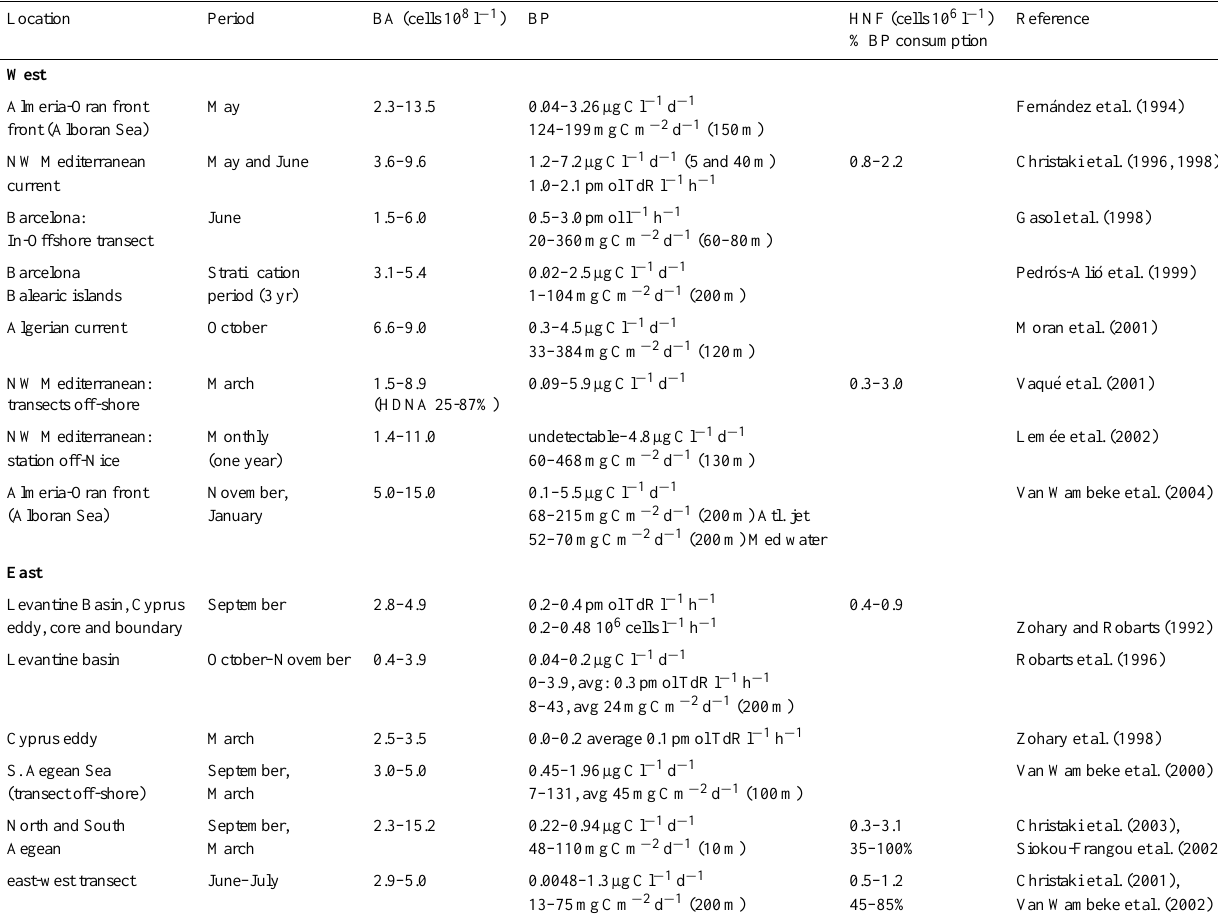
Table 5. Bacterial abundance (BA), Heterotrophic Nanoflagellate abundance (HNF) and Bacterial Production (BP) in different Mediterranean Sea areas. Note that BP is expressed in different units depending on the data given by the authors and depth (m) indicates tha maximum depth considered in the study. (TdR: 3H-thymidine incorporation, other BP are measured by 3H-leucine